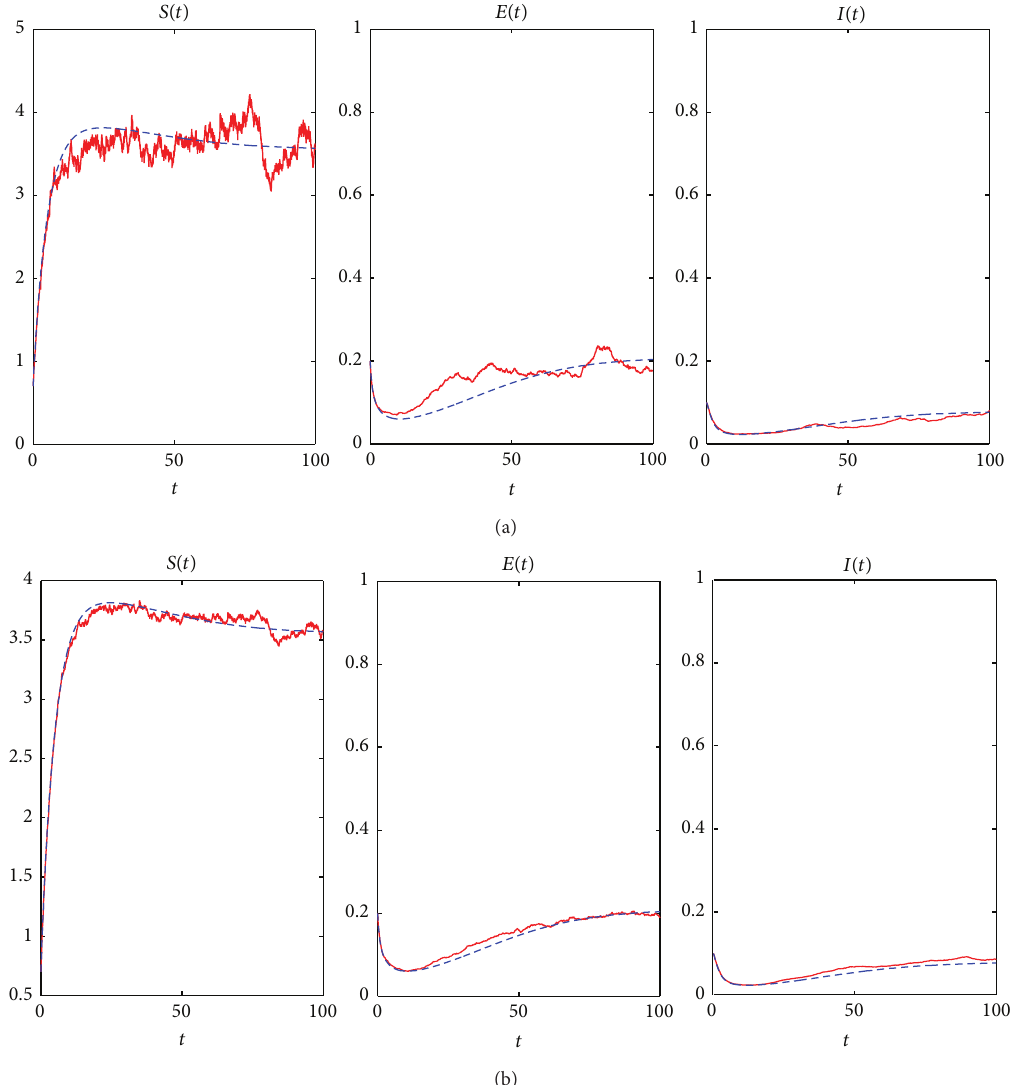
Figure 5: 𝑆(0) = 0.7 , 𝐸(0) = 0.2 , 𝐼(0) = 0.1 , Λ = 0.8 , 𝛽 = 0.6 , 𝜇 = 0.2 , 𝛿 = 0.2 , 𝛾 = 0.3 , 𝜖 = 0.3 , and 𝑑 = 0.4 . Group (a) 𝜎 1 = 0.04 , 𝜎 2 = 0.03 , and 𝜎 3 = 0.02 . Group (b) 𝜎 1 = 0.01 , 𝜎 2 = 0.02 , and 𝜎 3 = 0.01